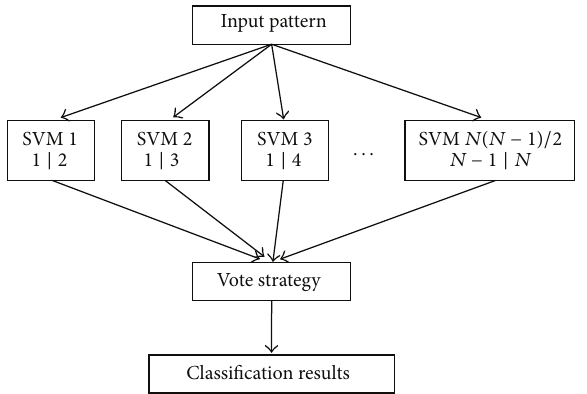
Figure 2: Schematic of OAO